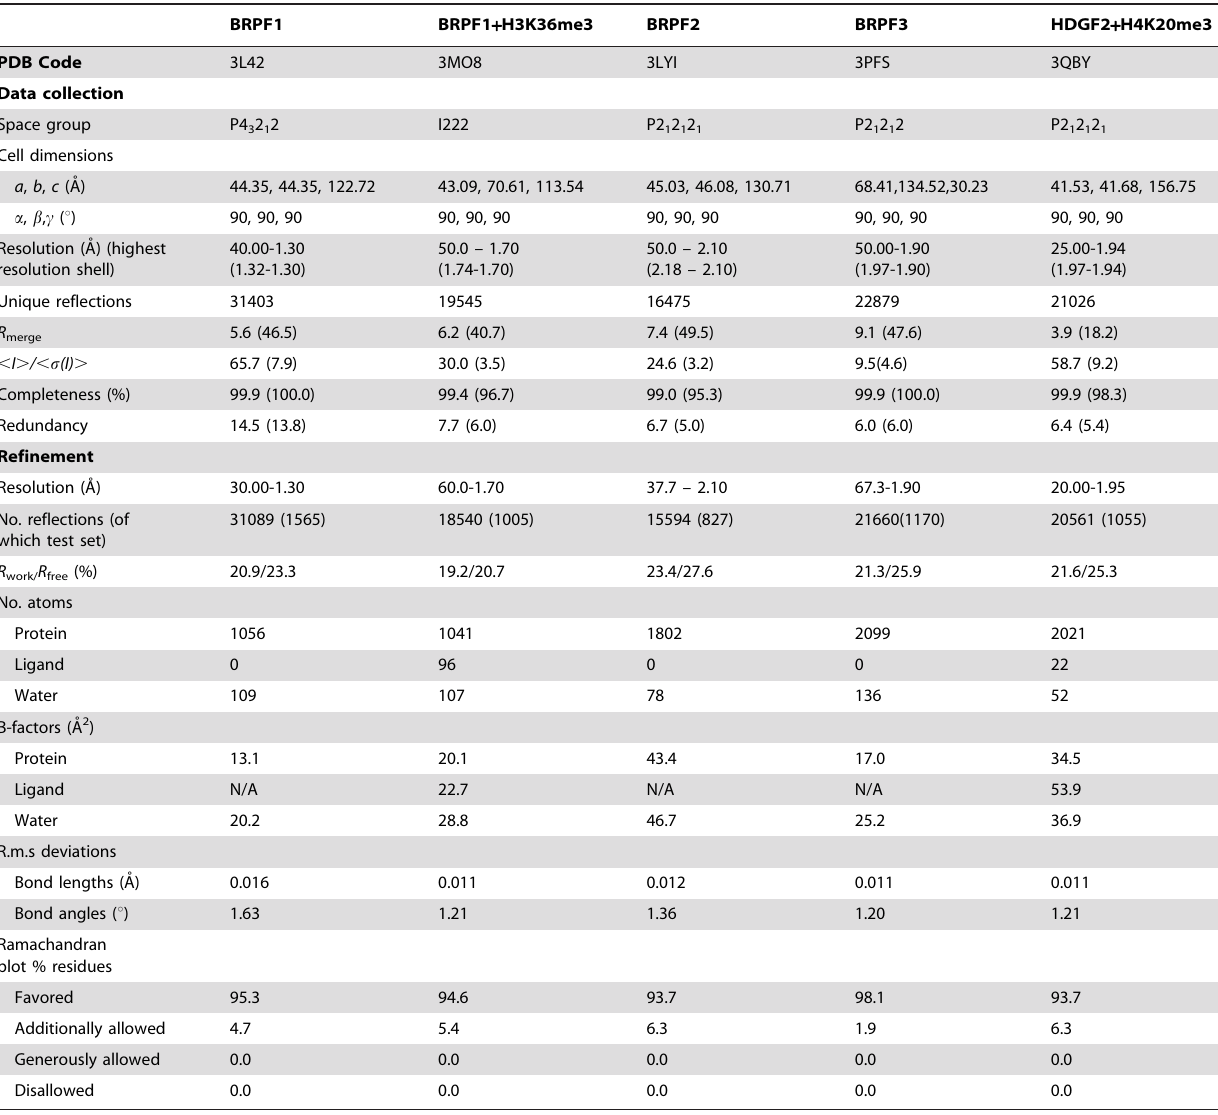
Table 2. Crystallography data and refinement